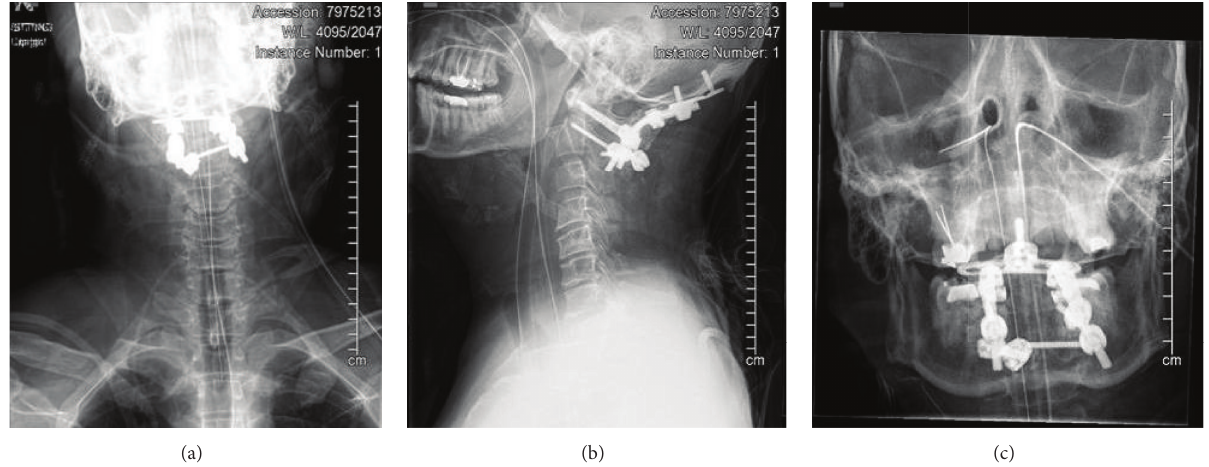
Figure 9: Postoperative imaging demonstrating a reduced and secured occiput to C2 posterior